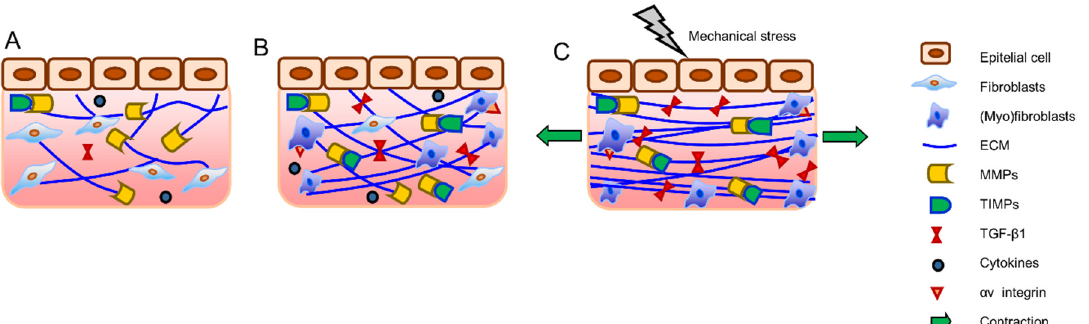
Figure 4. Fibrosis. ECM metabolism and turnover is dependent on the function of fibroblasts, MMPs, TIMPs, and the local tissue environment ( A ). TIMPs regulate MMP activity and directly inhibit ECM degradation, and the increase of TIMP function and release of TGF- β 1 results in excessive ECM deposition ( B ). In addition, activated (myo)fibroblasts express integrin receptors that connect TGF- β 1 and ECM components, resulting in fibrotic tissue with denser and straighter ECM fibers, which eventually leads to overall higher tissue stiffness. At this point, even smaller mechanical stresses applied to the fibrotic tissue will cause the release of more TGF- β 1 ( C ).